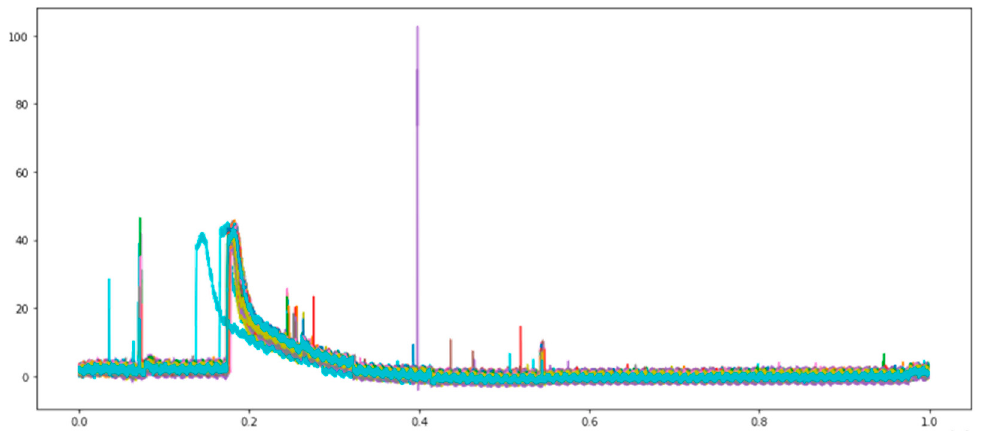
Figure 11. Graph of pressure curve variation.